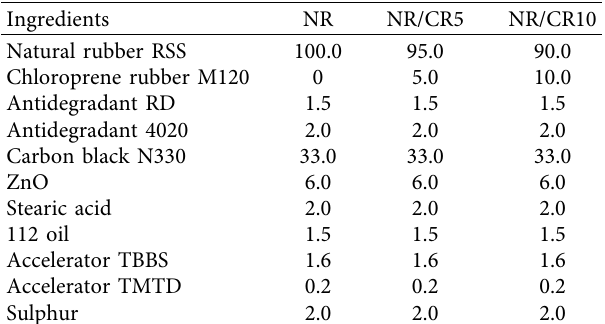
Table 1: Rubber blends formulations.